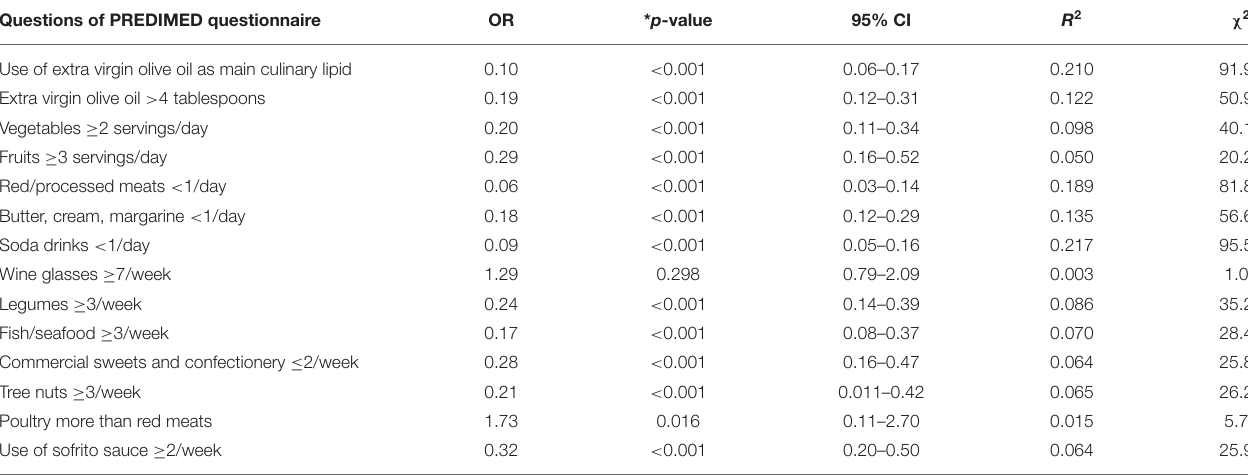
TABLE 9 | The bivariate proportional OR model performed to assess the association between the cytology categories (TIR2, TIR3a, TIR3b vs. TIR4/TIR5) and the responses of each item included in PREDIMED questionnaire. Questions of PREDIMED questionnaire